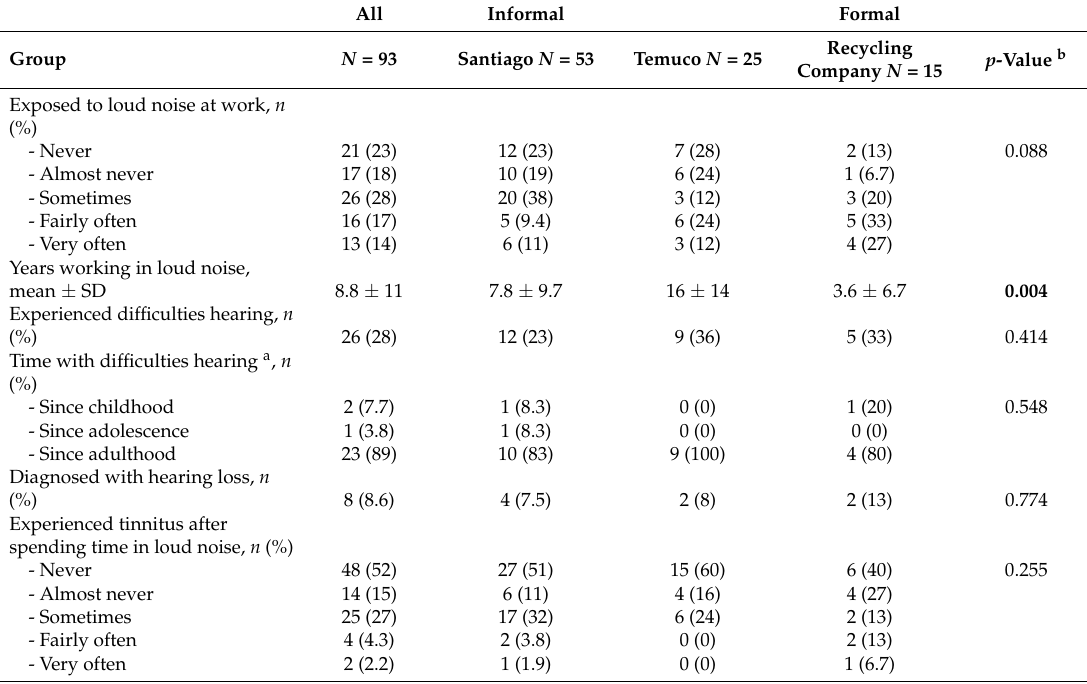
Table 6. Self-reported noise exposure in the study population, by job type and